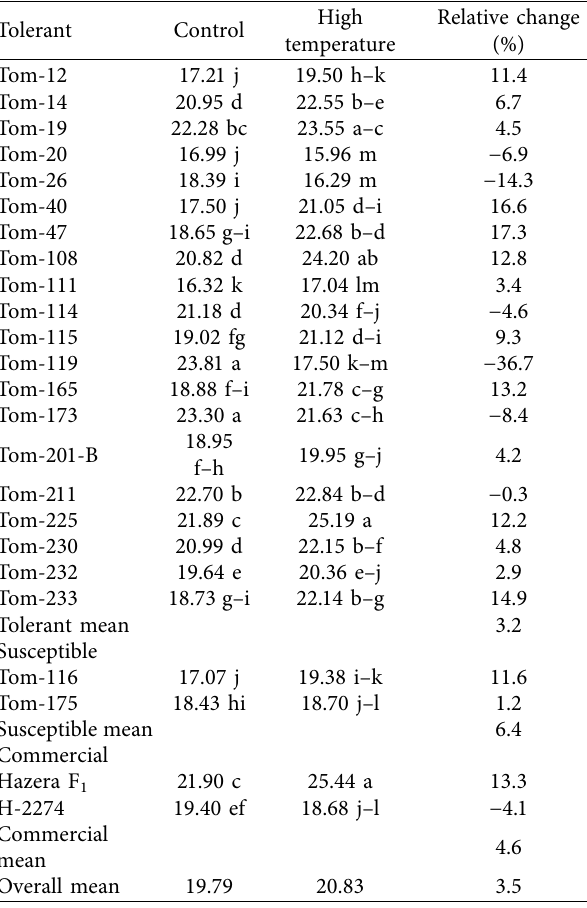
Table 9: Vitamin C of tomato fruits grown in control and high- temperature stress (mg/100 g